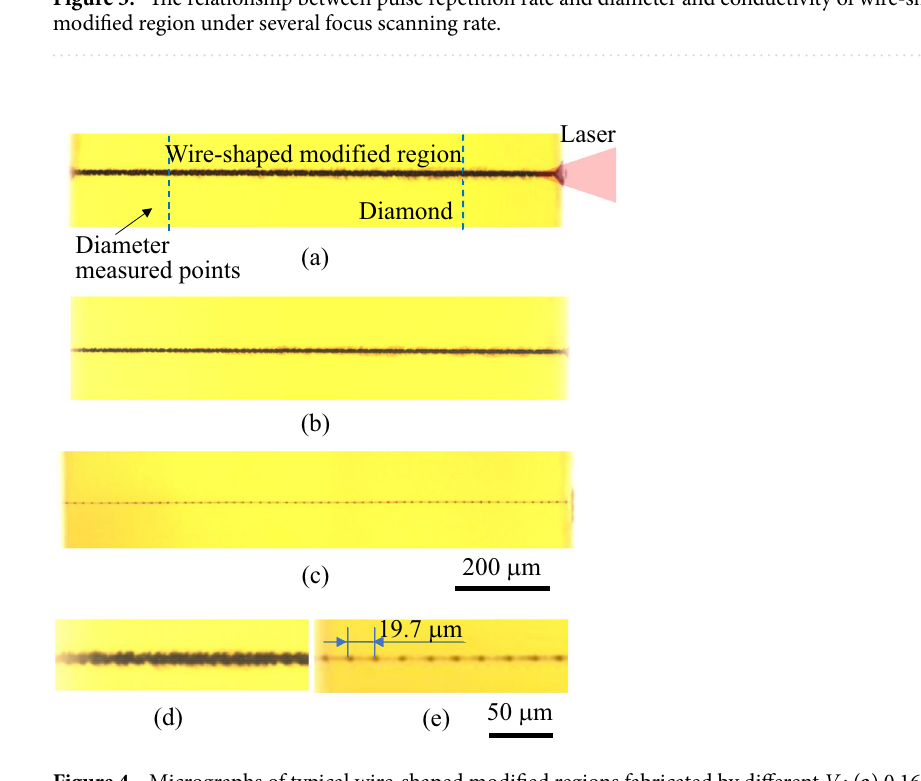
Figure 4. Micrographs of typical wire-shaped modified regions fabricated by different V f : ( a ) 0.16 μm/pulse, ( b ) 4.84 μm/pulse and ( c ) 19.36 μm/pulse. ( d ) and ( e ) are enlarged view of ( b ) and ( c ),